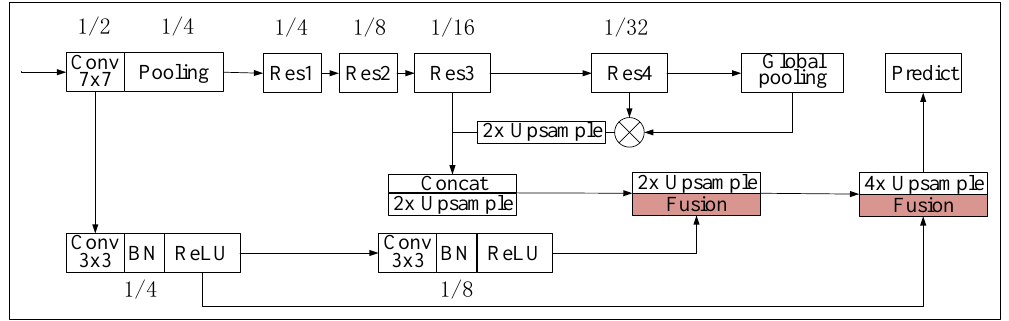
Figure 8. The baseline